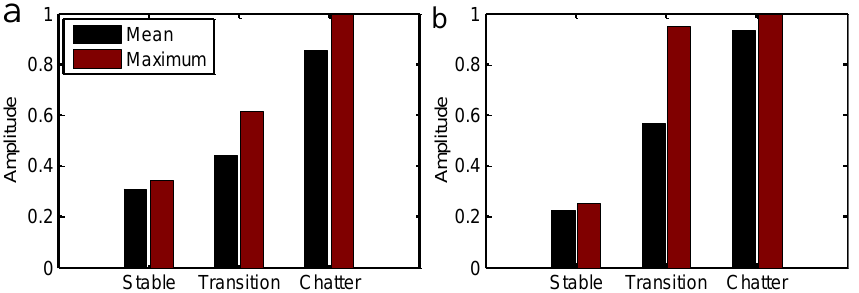
Figure 10. ( a ) Maximum and mean values of real-time variance; ( b ) maximum and mean values of instantaneous energy.